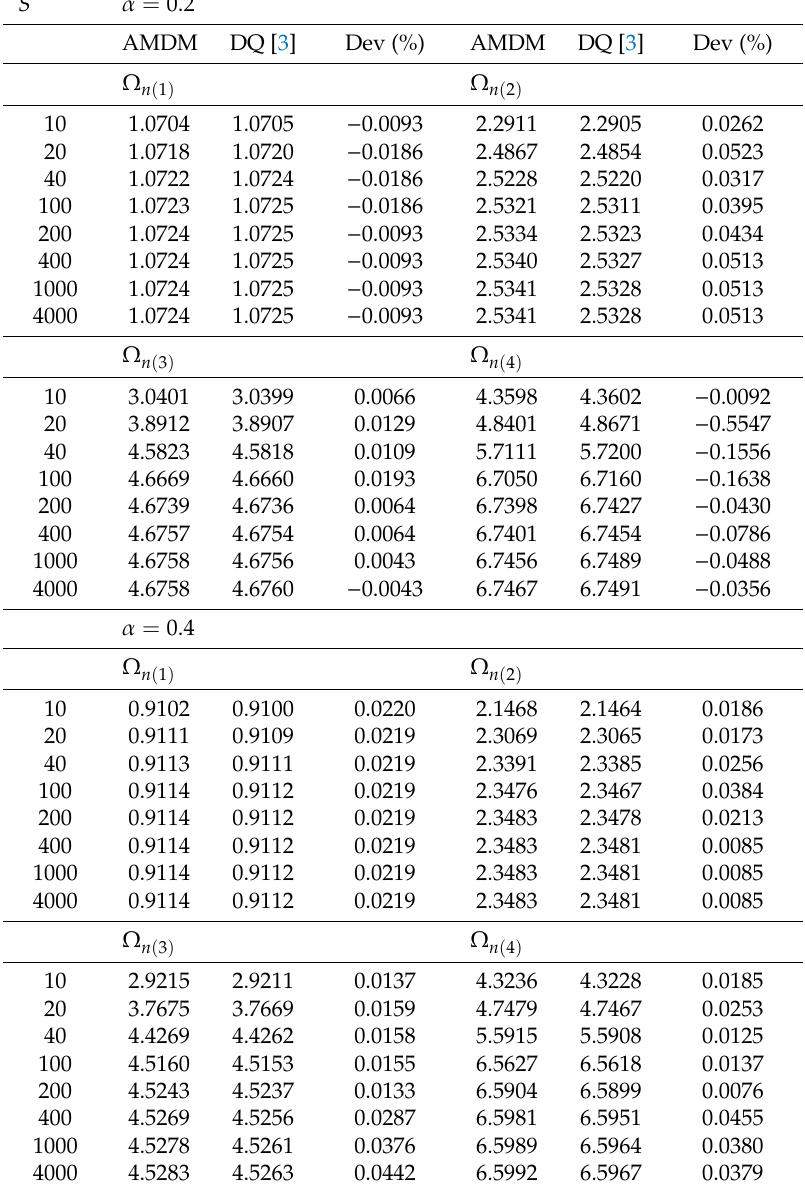
(cid:16) (cid:17) (cid:112) R θ 0 / I 0 / A 0 and under clamped-free boundary